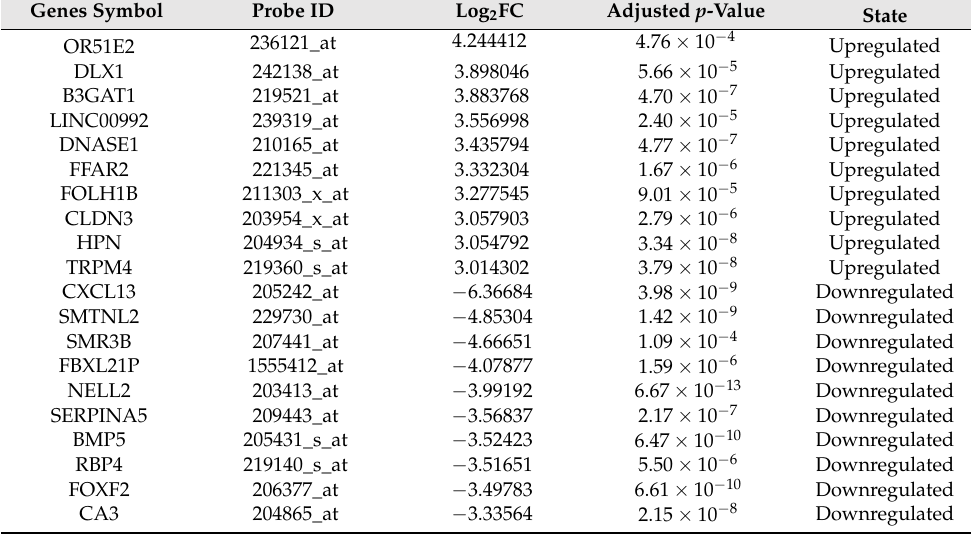
Table 1. The top 10 DEGs that were upregulated and downregulated between tumor and normal tissues. DEGs, differentially expressed genes; FC, fold